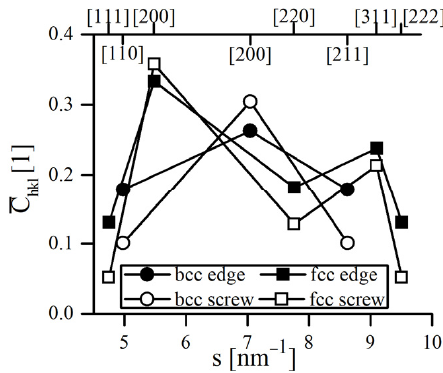
Figure 2. The average value of anisotropic contrast factor C versus the scattering vector s calculated for bcc and fcc microstructures of the Fe-18Cr-18Mn alloy, considering pure edge and pure screw dislocation